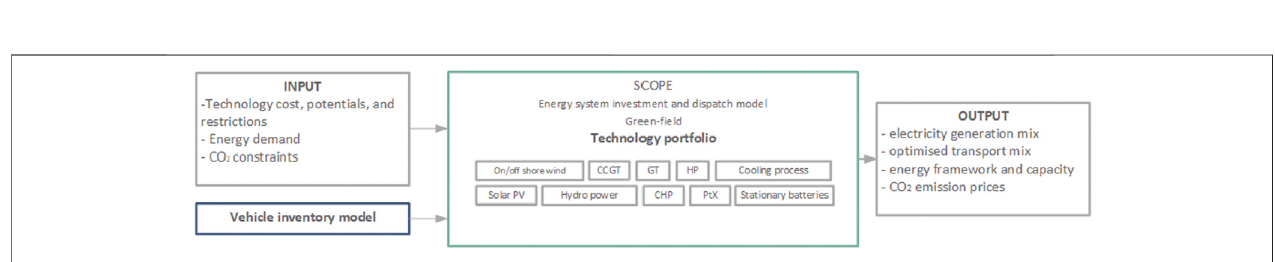
FIGURE 2 | Overview of the SCOPE-model, including the input and output data and the technologies in which investments can be made. CCGT, Combined cycle gas turbine; GT, gas turbine; CHP, combined heat and power; PtX, Power-to-X; PV, photovoltaic; HP, heat pumps.